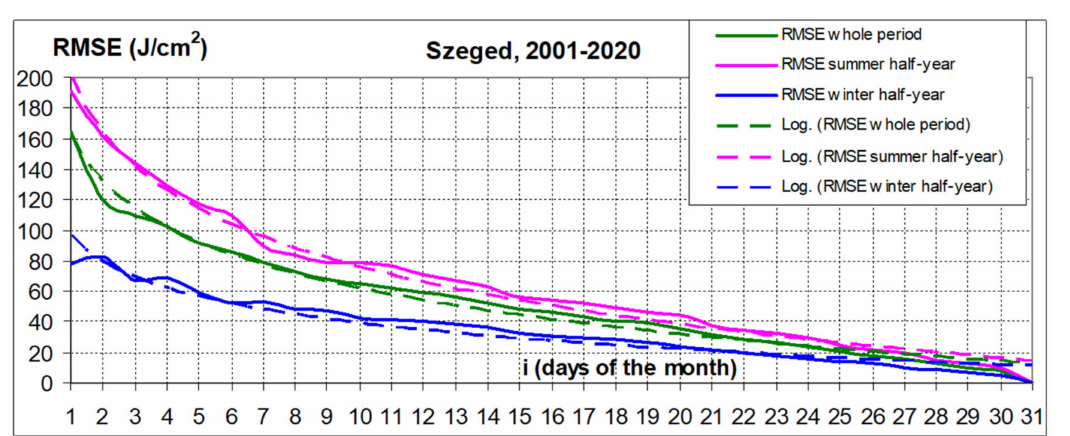
Figure 9. Monthly runs of the RMSE error parameter.